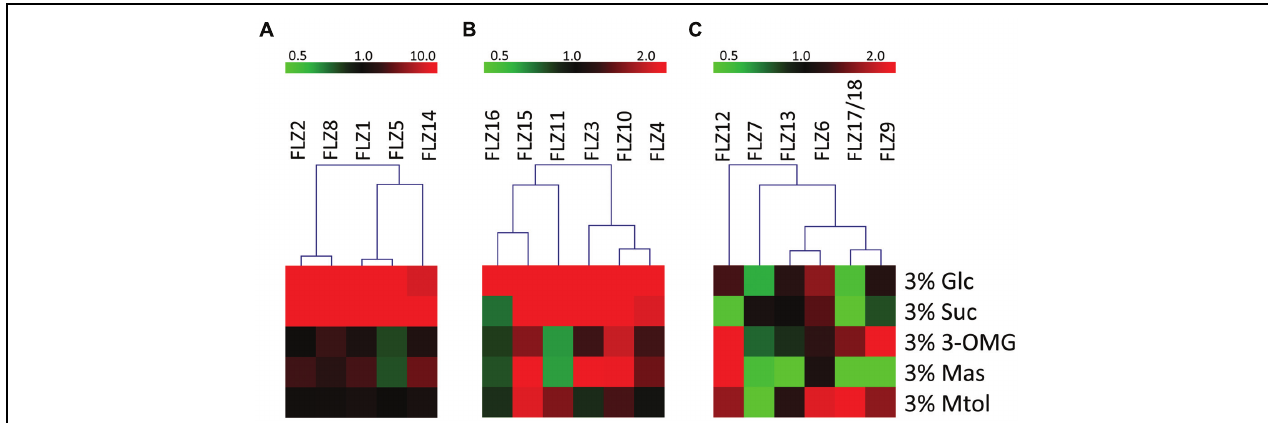
FIGURE 2 | Sugar sensitivity of Arabidopsis thaliana FLZ gene family. The A. thaliana FLZ gene family was classified into three groups based on their response toward sugar treatments in qRT-PCR experiments. The expression in 0% sugar grown plants was taken as the control for comparing the expression in other treatments and 18S rRNA was used as endogenous control. (A) High sugar-inducible genes (Class I, induced by ≥ 10 fold by glucose and/or sucrose). (B) Medium sugar-inducible genes (Class II, induced by ≥ 2 fold by glucose and/or sucrose). (C) Sugar non-responsive and sugar-repressible genes (Class III, significantly repressed by glucose and/or